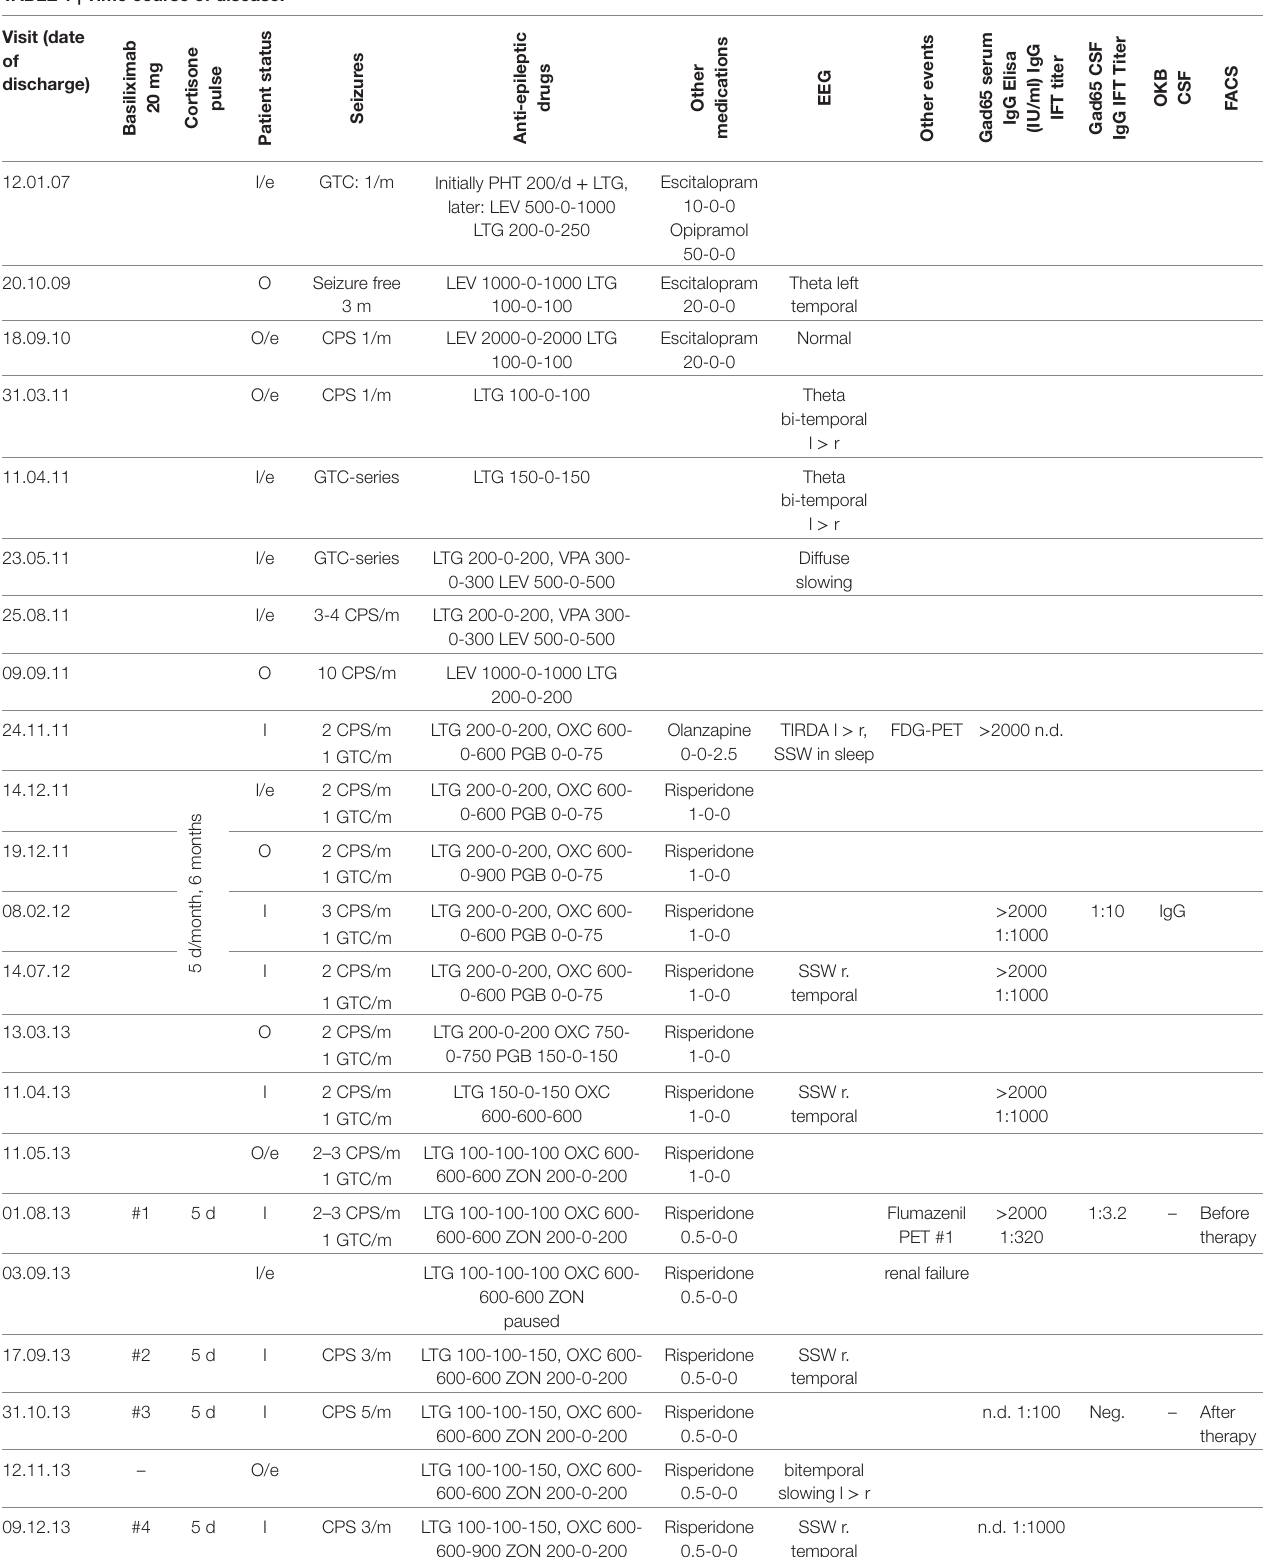
taBle 1 | time course of